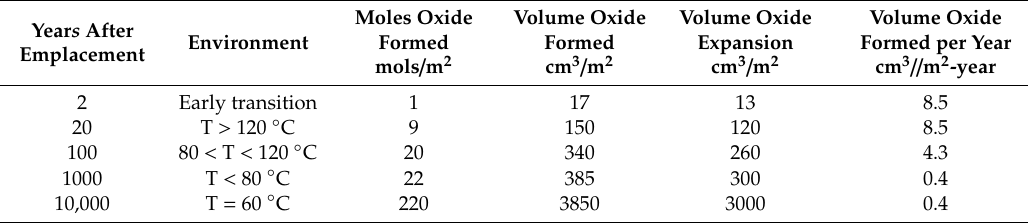
Table 7. Oxide formation per zone from Alloy 625